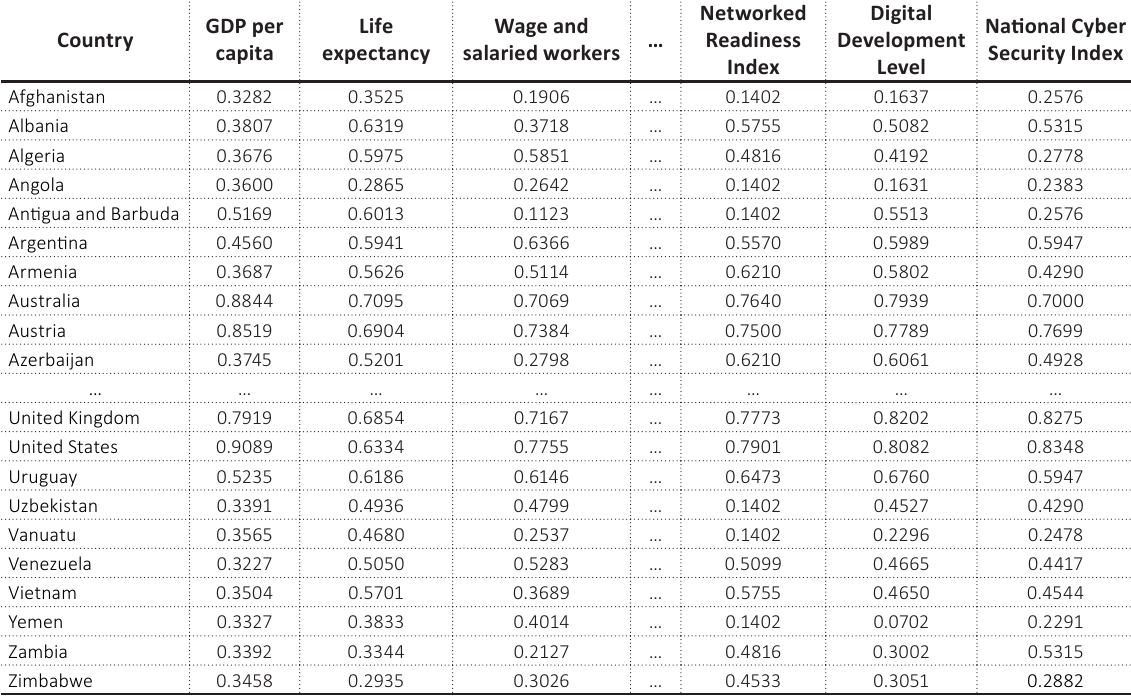
Table 2. Normalized components of the information security threat index (fragment)